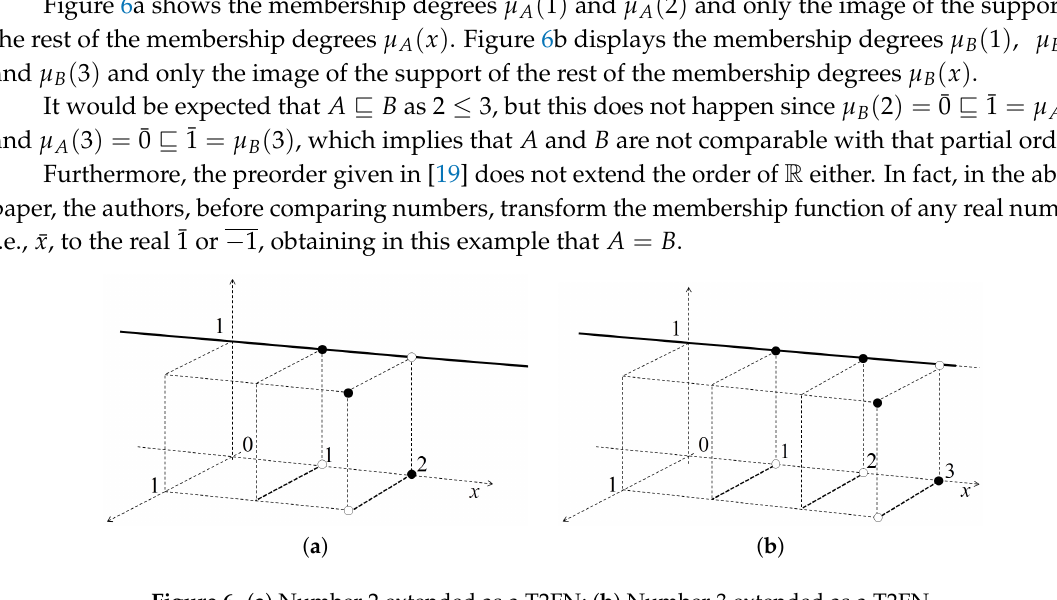
Figure 6. ( a ) Number 2 extended as a T2FN; ( b ) Number 3 extended as a